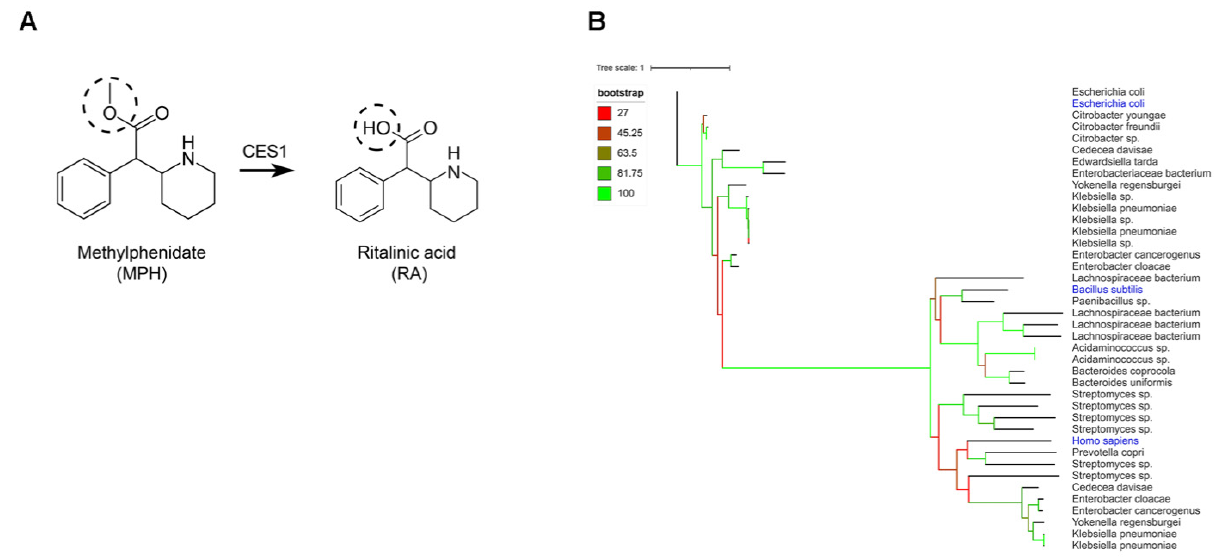
Figure 1. In silico analysis of bacterial homologues of the human carboxylesterase 1. ( A ) Hydrolysis reaction by human carboxylesterase 1 (CES1), which removes a methyl group from methylphenidate (MPH) to form ritalinic acid (RA). ( B ) Phylogenetic trees created using iTOL online tool showing gut bacterial strains harboring homologue enzymes of human CES1, E. coli yjfP and B. subtilis pnbA, respectively.